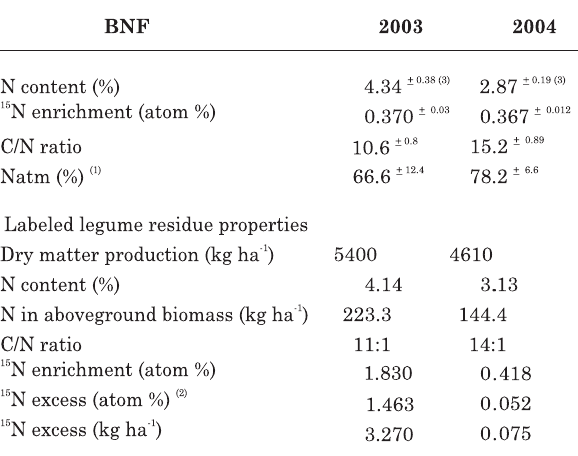
Table 1. Efficiency of biological nitrogen fixation (BNF) of hairy vetch and isotopic properties